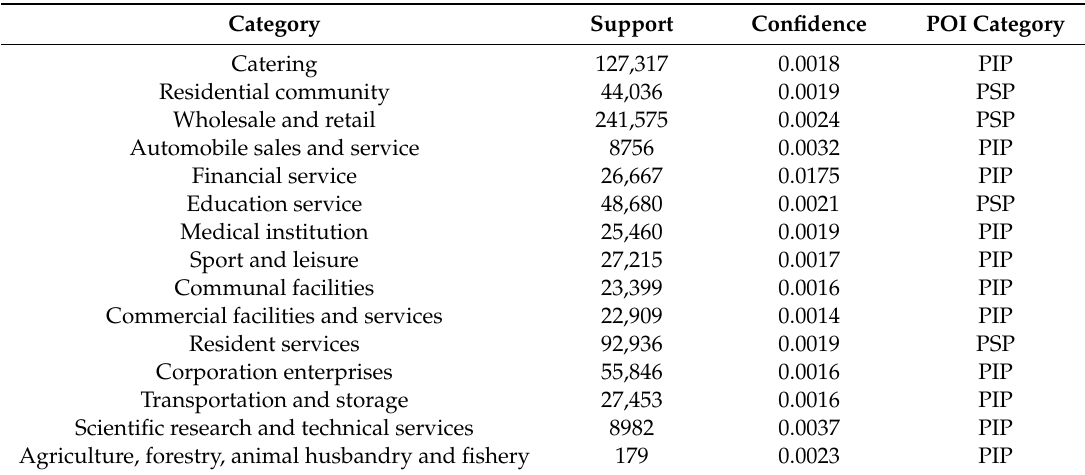
Table 3. The support and confidence of the association rule between population gathering points and each category of